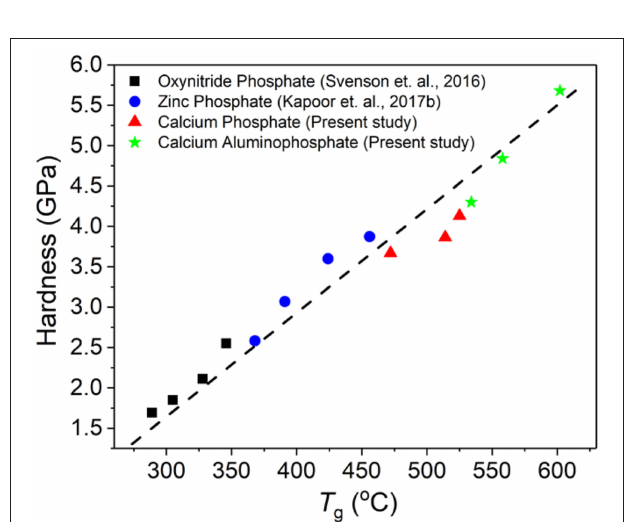
FIGURE 9 | Relationship between Vickers hardness ( H v ) and T g for various phosphate-based glasses (Svenson et al., 2016; Kapoor et al., 2017b). All the H V values in the figure are obtained from tests conducted at 0.05 kgf load.